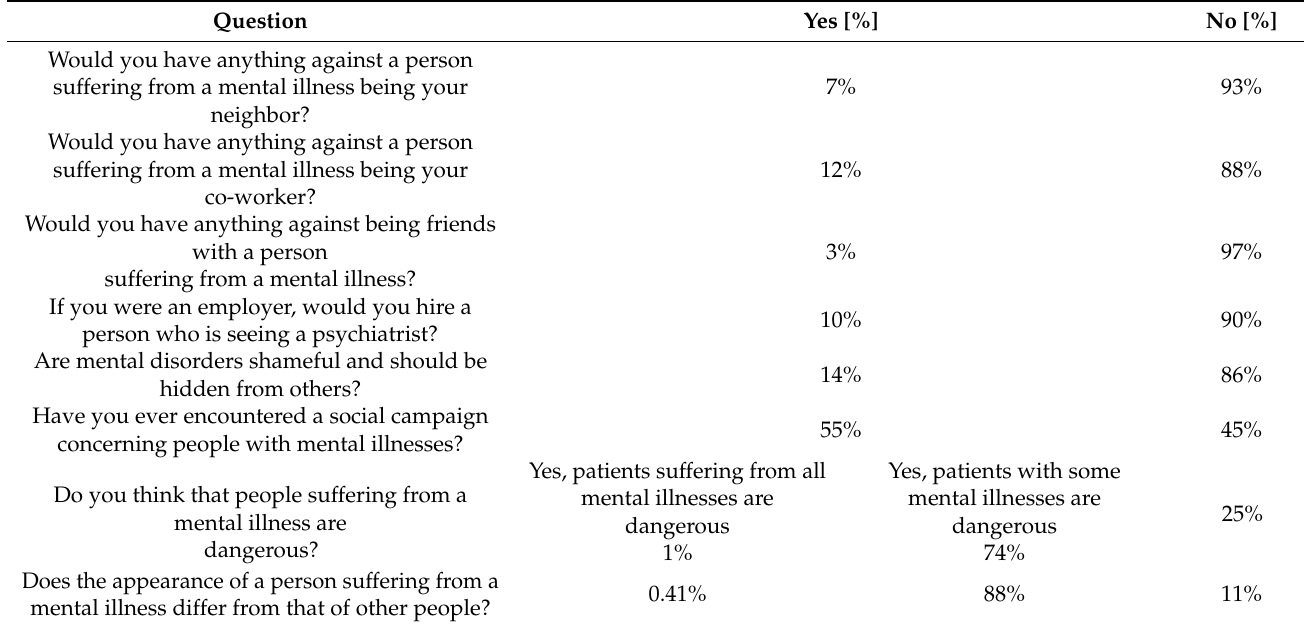
Table 2. Distribution of answers of respondents assessing the level of